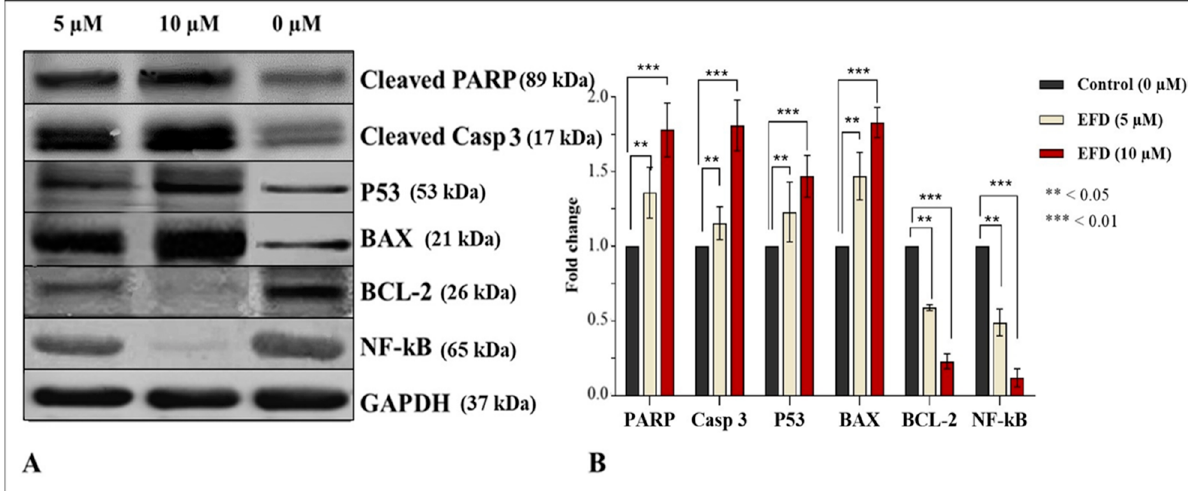
Figure 4. Western blot analysis of proteins associated with EFD induced apoptosis. Note: ( A ) The data demonstrate enhanced caspase 3 cleavage and downstream PARP, upregulation of pro-apoptotic P53 and BAX while downregulation of antiapoptotic NF- κ B and BCL2. The loading control used was GAPDH. ( B ) Fold change comparative to control in cleaved PARP, Casp 3, P-53, BAX, BCL-2 and NF- κ B expression after 48 h treatment with EFD.